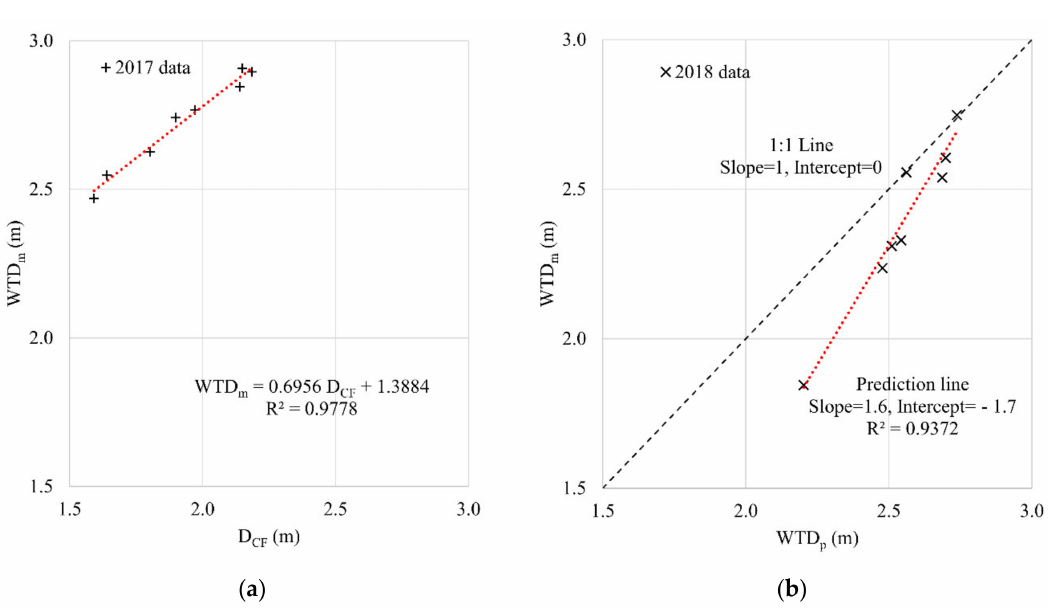
Figure 7. ( a ) Linear regression plot of measured water table depth (WTD m ) vs. ground penetrating radar (GPR) estimated depth to the capillary fringe (D CF ) for 2017 data ( n = 8). ( b ) The 1:1 plot of the predicted water table depth (WTD p ) vs. WTD m in 2018 ( n =